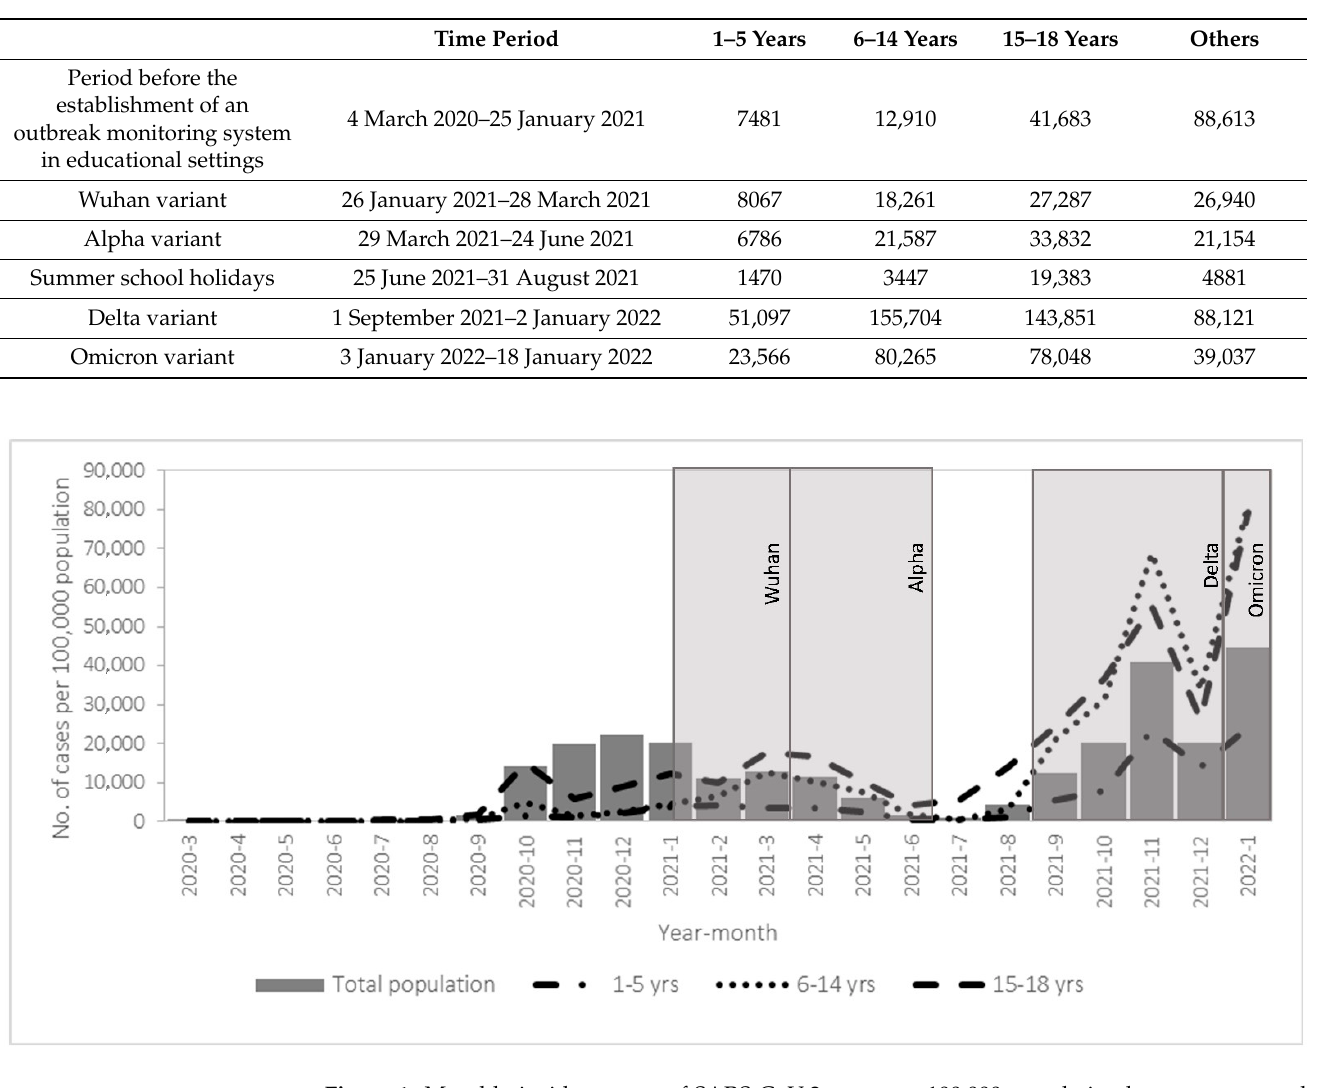
Table 5. Representation of the fulfilled COVID-19 outbreak criteria in educational settings in Slove- nia in the period from 26 January 2021 to 18 January 2022, taking into account the periods of pre- dominance of each SARS-CoV-2 variant in Slovenia.